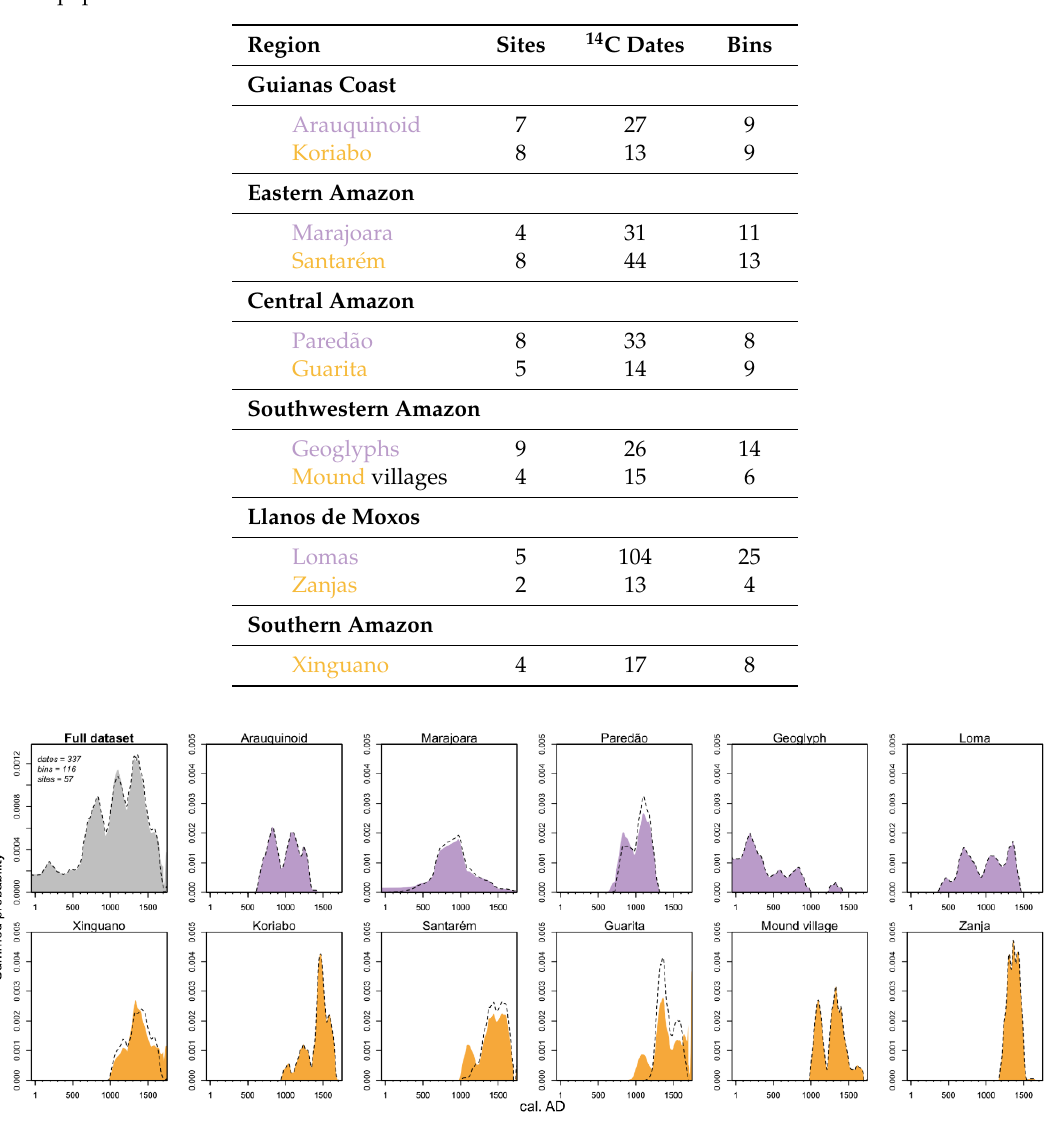
Table 1. Summary of dataset employed here. “Intensive” phases are in purple and roughly precede “extensive” phases in time, which are shown in orange. This convention is used consistently throughout this paper.